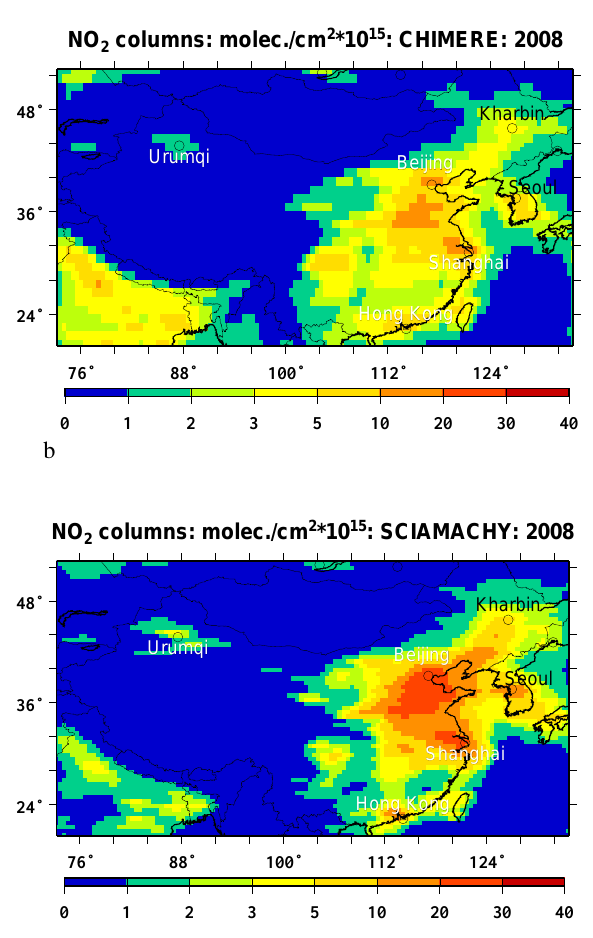
Fig. 1. Annual mean tropospheric NO 2 column amounts (molecules × 10 15 cm − 2 ) simulated with the CHIMERE model (a) and derived from SCIAMACHY measurements (b) for the year 2008.